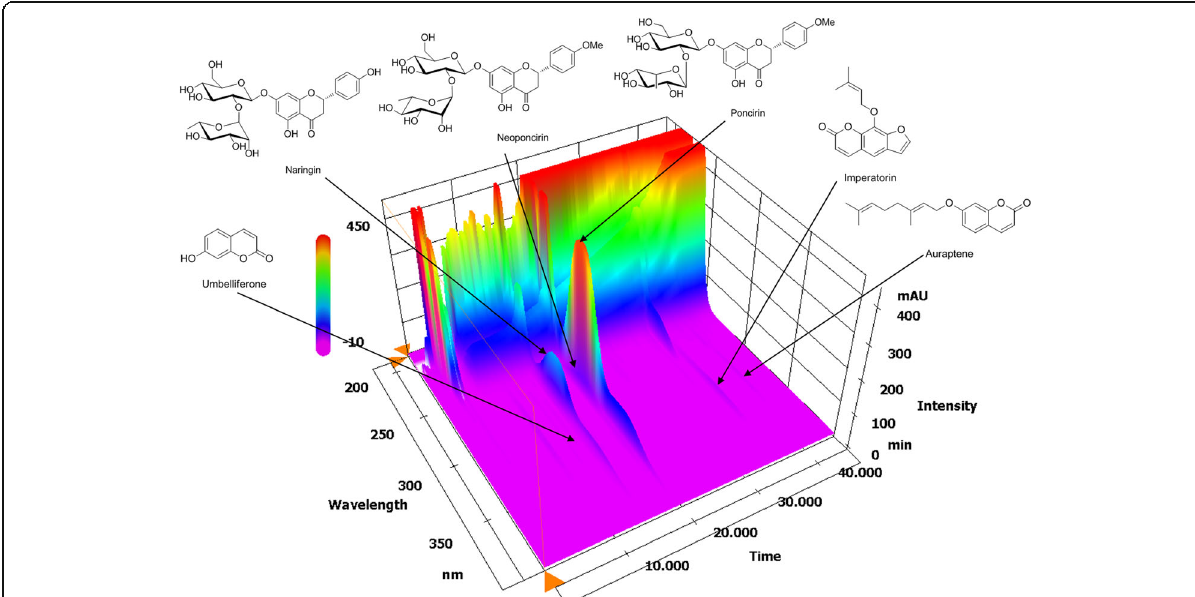
Fig. 2 Three-dimensional chromatogram of Ponciri fructus extract by HPLC-PDA. HPLC-PDA, high-performance liquid chromatography-photodiode array detector